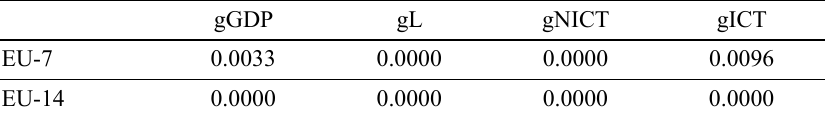
Table 1. Probability of ADF panel unit roots tests for examined